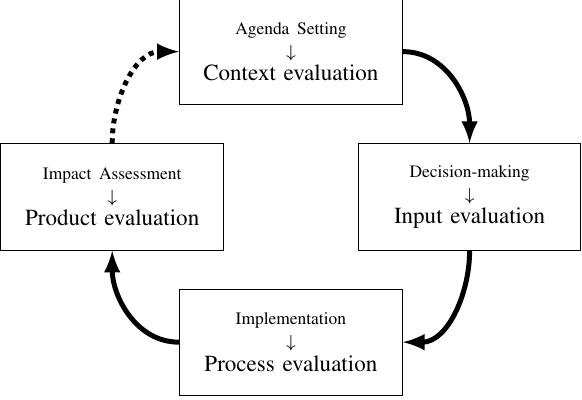
Figure 1. A regular policy cycle contains four phases, each requiring a different type of evaluation